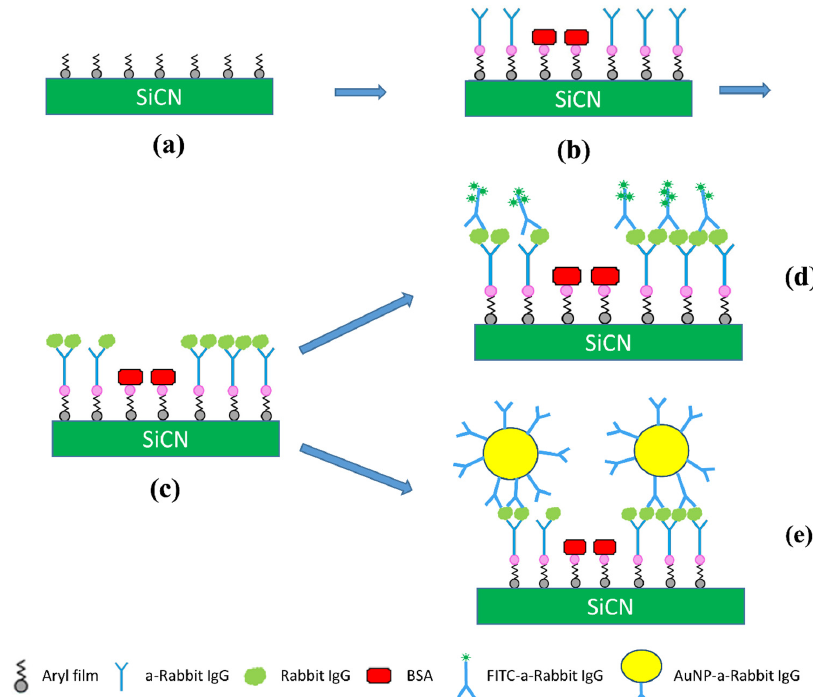
Figure 2. Schematic diagram of rabbit IgG sandwich assay onto SiCN surfaces. ( a ) grafting of aryl groups, as described in Figure 1; ( b ) activation of carboxyl groups and attachment of anti-rabbit IgG and BSA blocking layer; ( c ) specific capture of rabbit IgG; ( d ) tagging using FITC-labelled anti-rabbit IgG; ( e ) tagging using gold nanoparticles functionalized with anti-rabbit IgG.